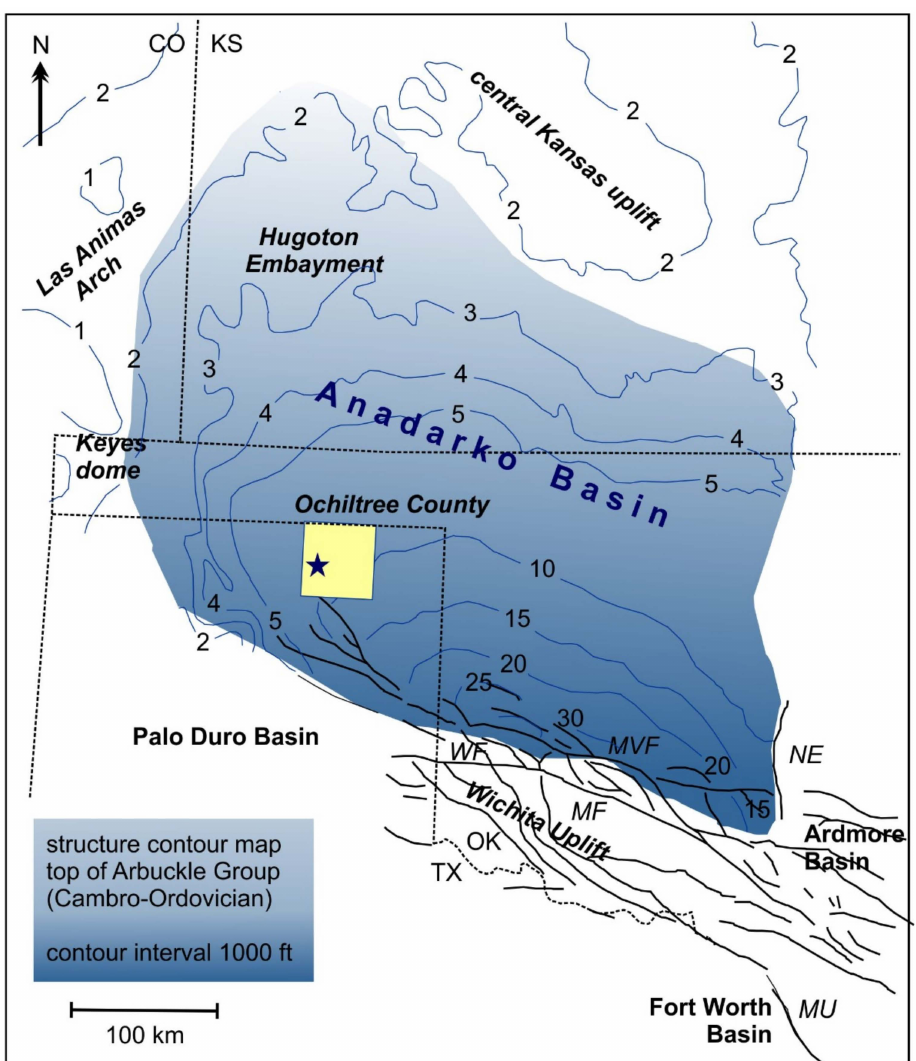
Figure 1. Location of the study site (dark blue star) in Ochiltree County (yellow) in the western Anadarko Basin (blue). Modified from [6]. Contours: depth to top Arbuckle Group. The Arbuckle Group is below the Morrow B reservoir, and pre-dates the basin’s flexural subsidence phase. Contour interval 1000 ft below surface. Black solid lines: major faults. MF = Meers fault zone, MU = Muenster Arch, MVF = Mountain View fault zone, NE = Nemaha uplift, WF = Willow fault zone. Dashed black lines are state boundaries: CO = Colorado, KS = Kansas, OK = Oklahoma, TX = Texas. See Figure 2 for details and the location of Farnsworth